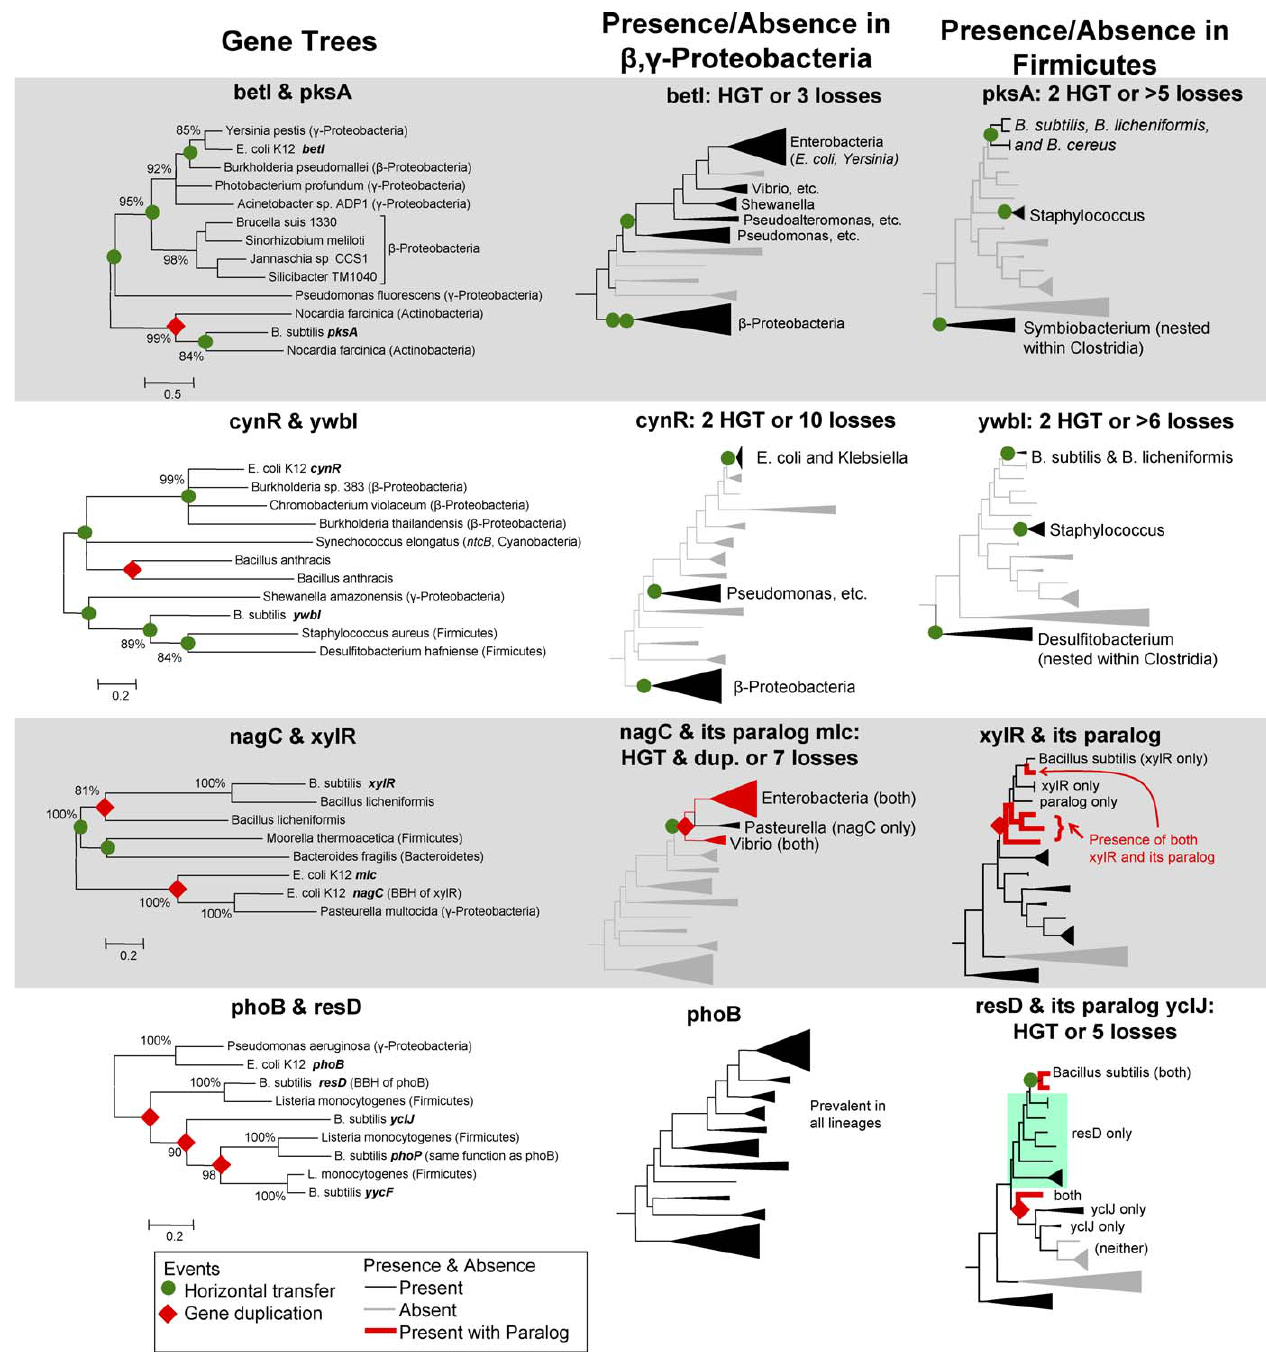
Figure 2. Evolutionary Histories of ‘‘ Orthologous ’’ Transcription Factors from E. coli K12 and B. subtilis (Left panels) For each pair of BBHs, we selected illustrative homologs and constructed a gene tree with TreePuzzle [43]. For confident clades, we show the support values. Close homologs from distantly related taxa are evidence for horizontal transfer events, and close homologs within one genome (i.e., paralogs) are evidence for duplication events. The rooting is arbitrary. (Center panels) The presence and absence of close homologs of the E. coli gene within b , c -Proteobacteria, and the number of loss events required to explain the gene’s distribution if HGT did not occur. (Right panels) Presence/absence of close homologs of the B. subtilis gene within Firmicutes. and yjeB/yhdE) show conservation within close relatives of B. events of HGT or gene duplication, including at least one HGT event, and four BBHs were rejected as one-to-one subtilis and E. coli and seem to have been transferred between evolutionary orthologs purely because of closer paralogs. them, so we classified these as xenologs. Another BBH, birA, Among the seven remaining BBHs, two of them (yjdG/yufM shows conservation within Bacilli and within c -Proteobac-